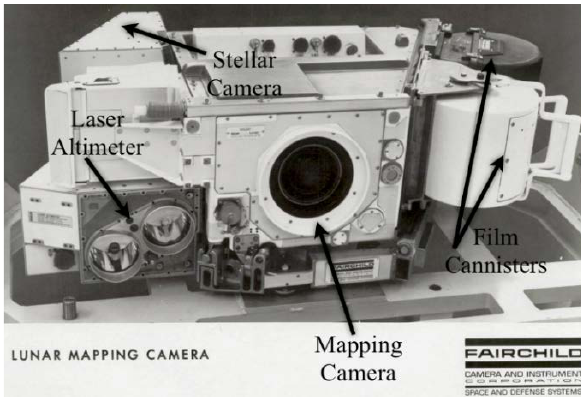
Figure 3: Apollo Lunar Mapping Camera System